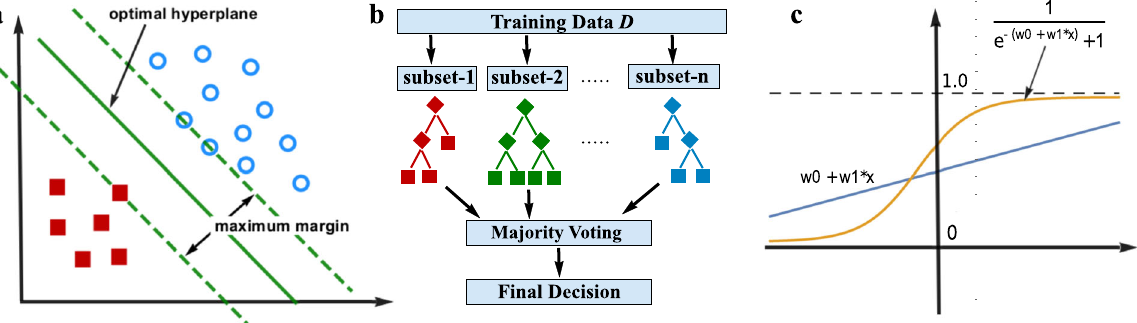
Fig. 1 Illustration of three baseline machine learning models. a Support Vector Machine: red squares and blue circles represent data from different classes. The optimal decision plane achieves the largest separation, or margin, between the two classes. b A Random Forest with n decision trees. Each tree is trained with a randomly sampled subset of training data. Predictions from all trees are combined using majority voting to produce a fi nal decision. c Logistic Regression with one dependent variable. The blue line is the linear regression model of the observed data. The sigmoid function transforms the linear model ’ s predictions into values between 0 and 1, which indicate the observations ’ likelihood of belonging to the positive